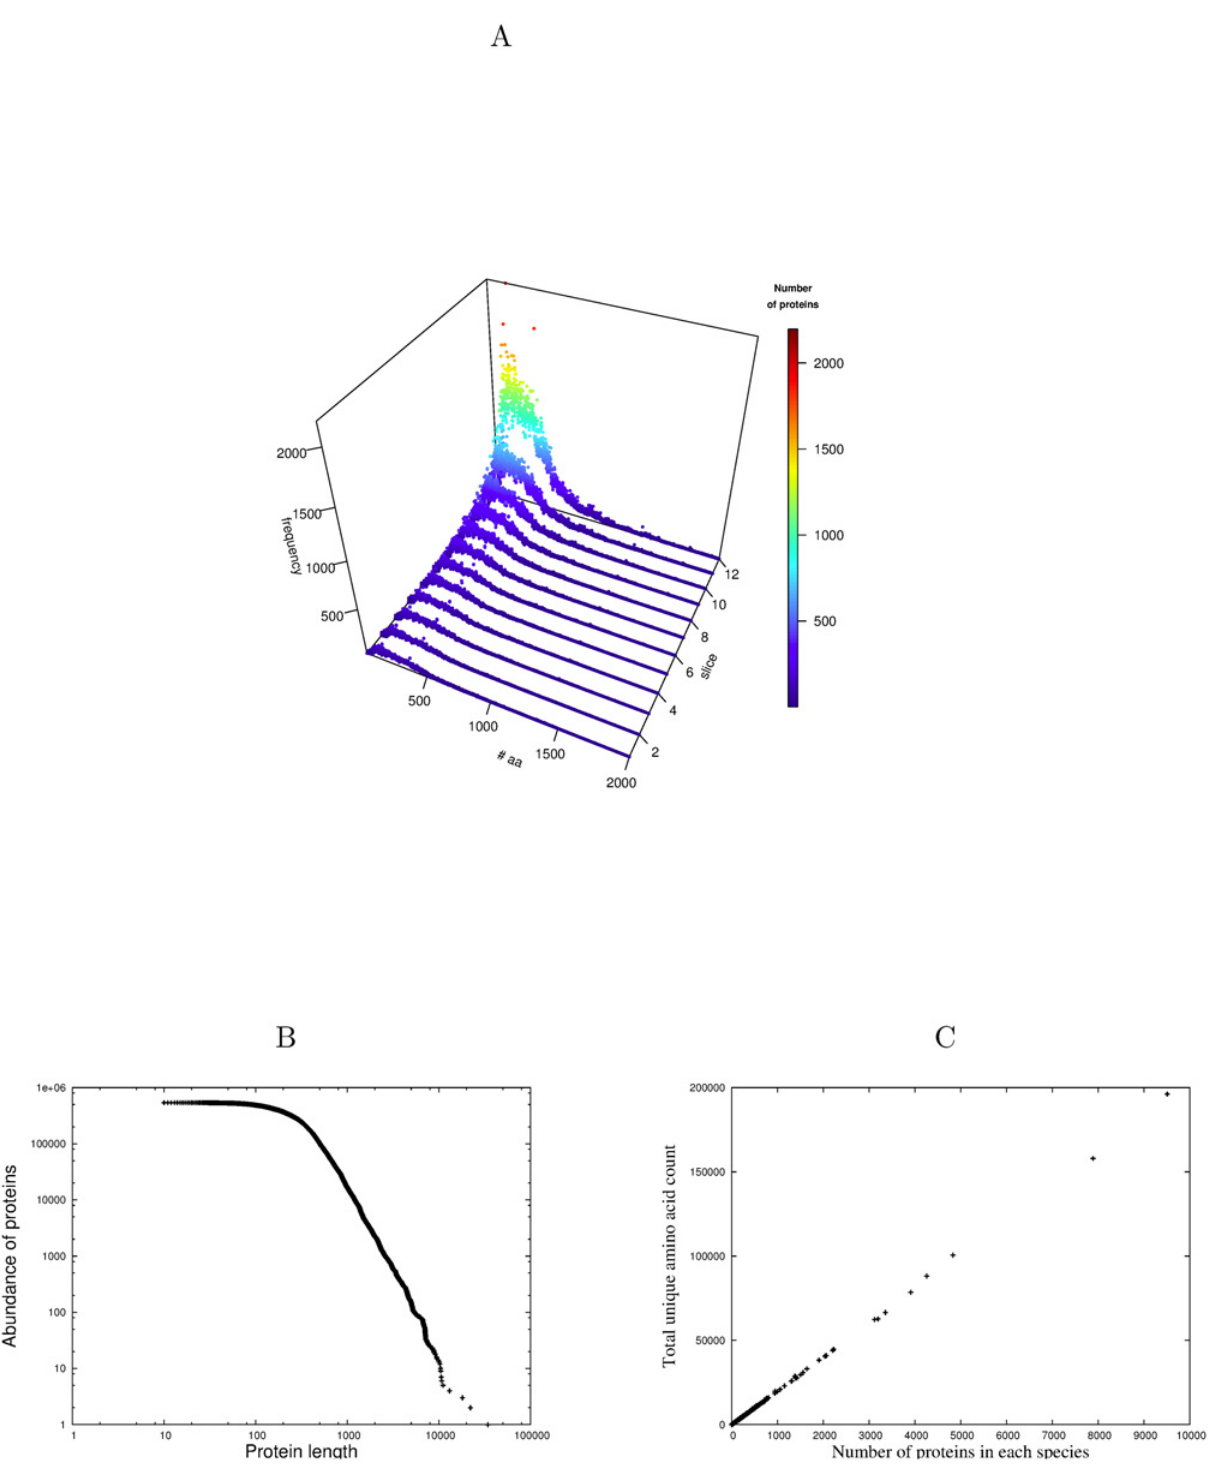
Fig 3. Power-law distribution of protein lengths. A The emergence of the protein length distribution with randomly increasing subsets of data from the full SwissProt database. B The length distribution of all proteins plotted as a log-log cumulative distribution function illustrating the emphatic power-law tail. C A plot of number of proteins against total length of their unique amino acid counts for each species in SwissProt for protein lengths from 100 – 500 amino acids. Each data point is a species.